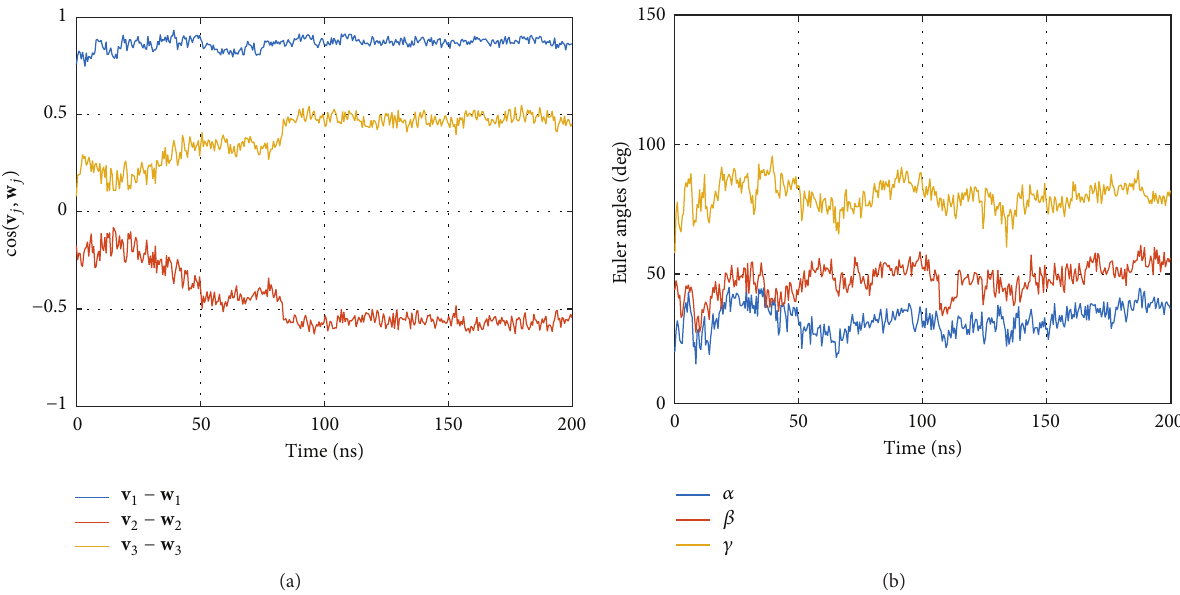
Figure 6: Relative Orientation of CD8 and MHC 𝛼 3 . (a) Cosine values between corresponding eigenvectors (see legend box) of both domains over time. Every 10th frame is plotted. (b) Euler angles for the same data.